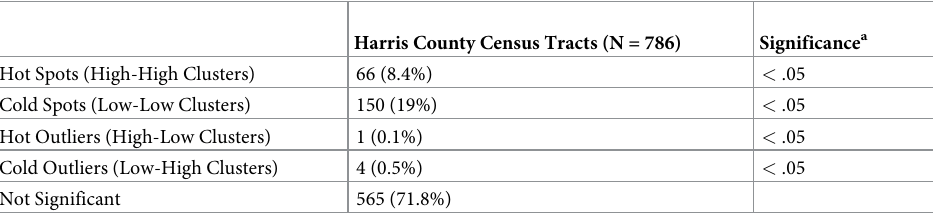
Table 1. Cluster and outlier analysis of food insecurity incidence, by census